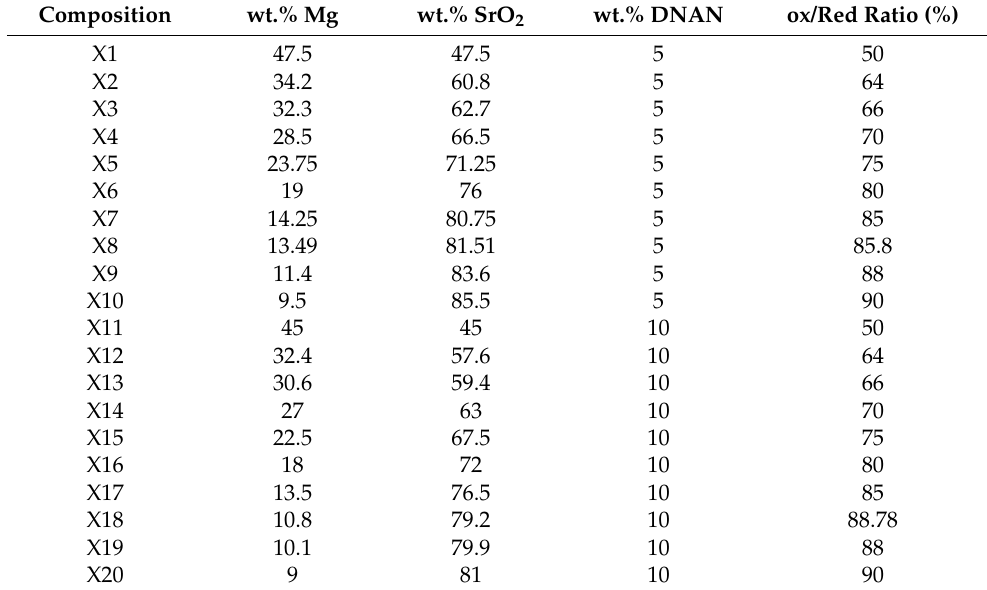
Table 2. Ternary compositions formulation with ox/red